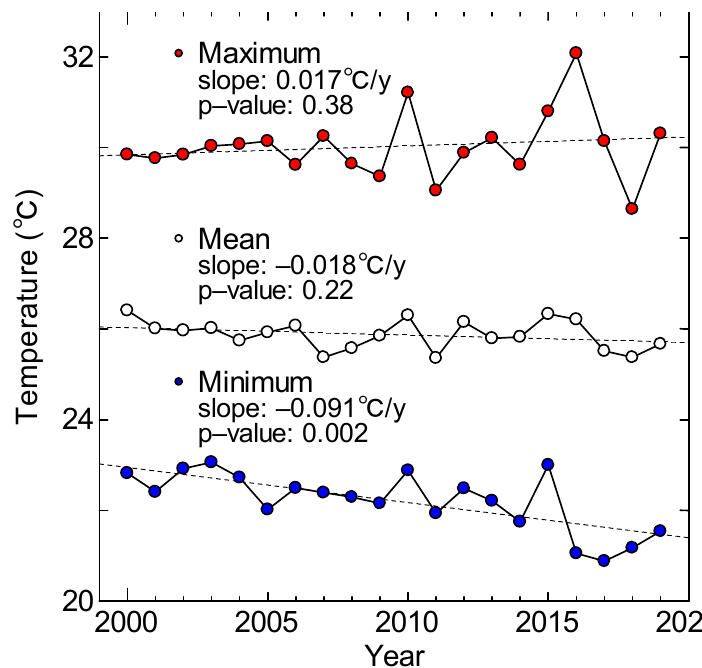
Figure 5. Trends of daytime water temperatures in the Tonle Sap Lake.